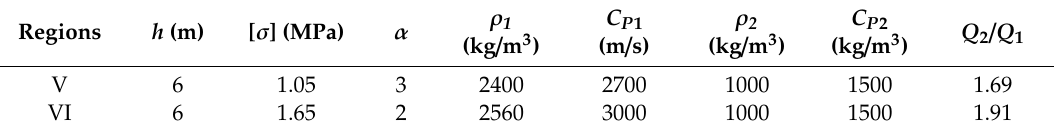
Table 2. Relevant parameters of underwater